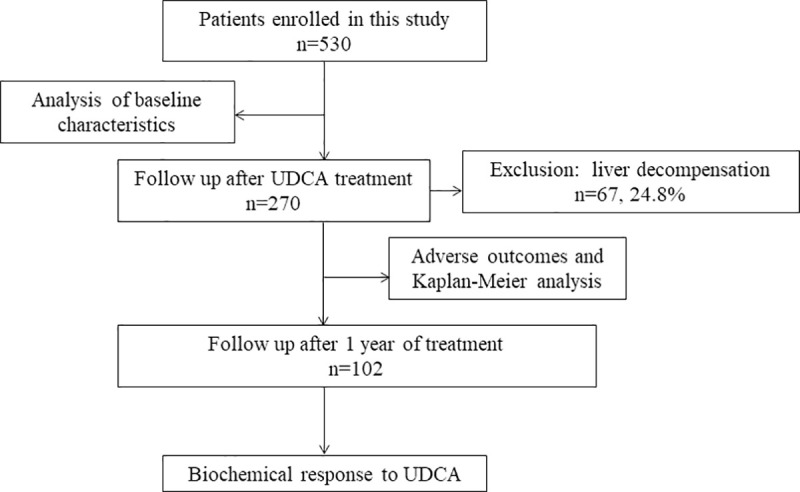
Patient flow chart.